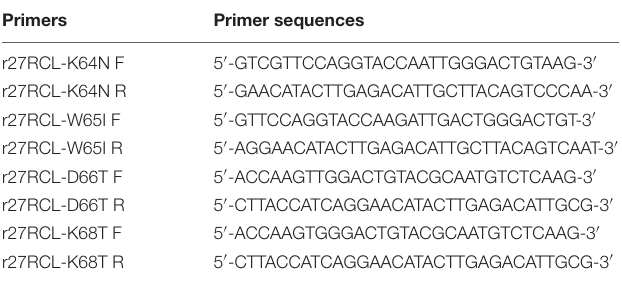
TABLE 1 | Oligonucleotide primers for Lipr27RCL-K64N, Lipr27RCL-W65I, Lipr27RCL-D66T, and